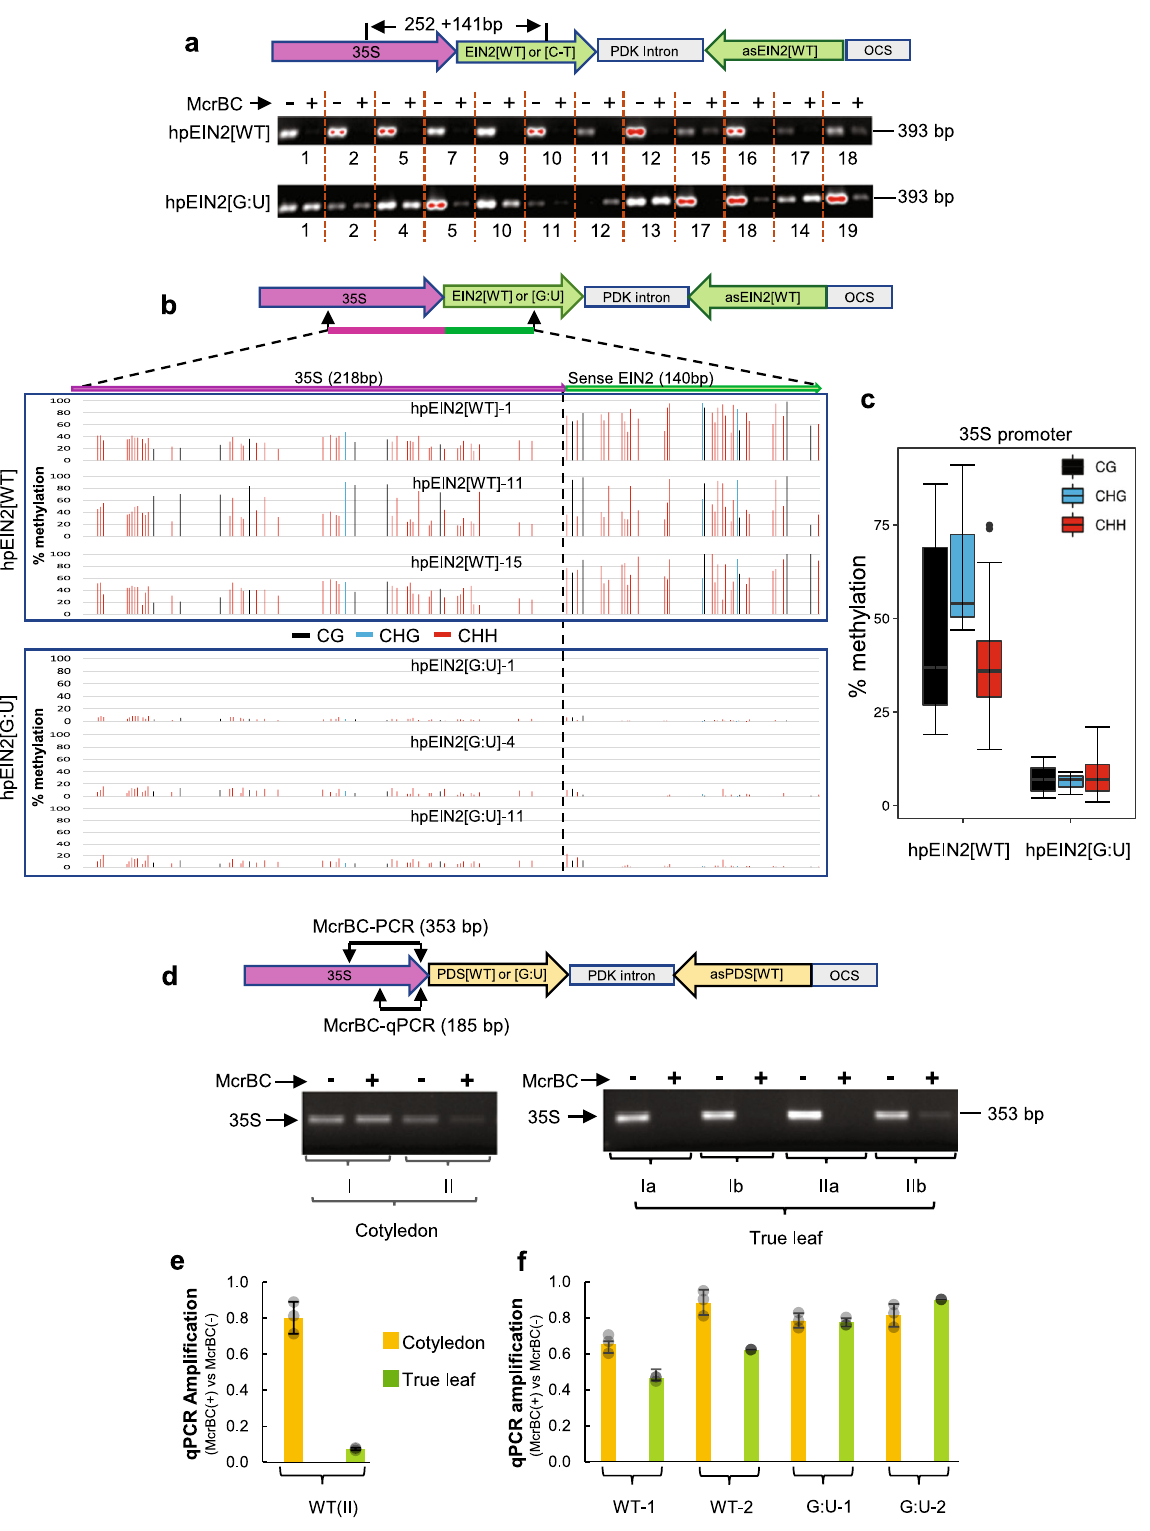
determine low DNA methylation levels, we performed bisul fi te sequencing on two hpGUS[WT] and four hpGUS[G:U] lines that had strong RNAi (indicated by asterisks in Fig. 4a). Consistent with the McrBC-digestion PCR result, all four hpGUS[G:U] lines had very low levels of DNA methylation at the 35S promoter based on bisul fi te sequencing (Fig. 4c, d). The two hpGUS[WT] lines, despite strong RNAi, both showed moderate levels of DNA